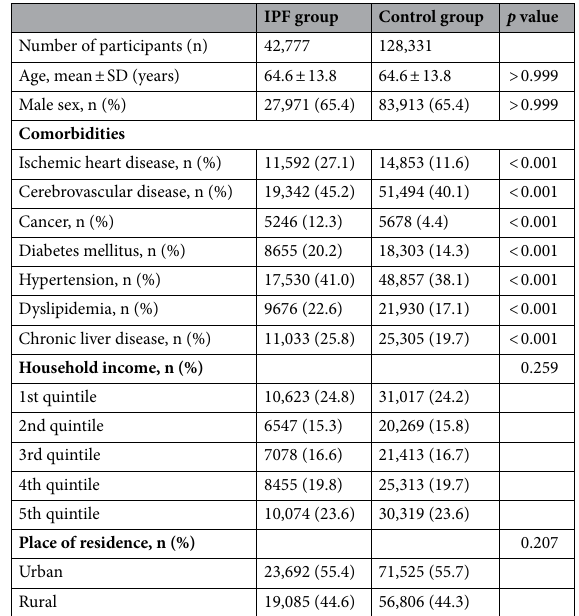
Table 1. Baseline participant characteristics. IPF idiopathic pulmonary fibrosis, SD standard